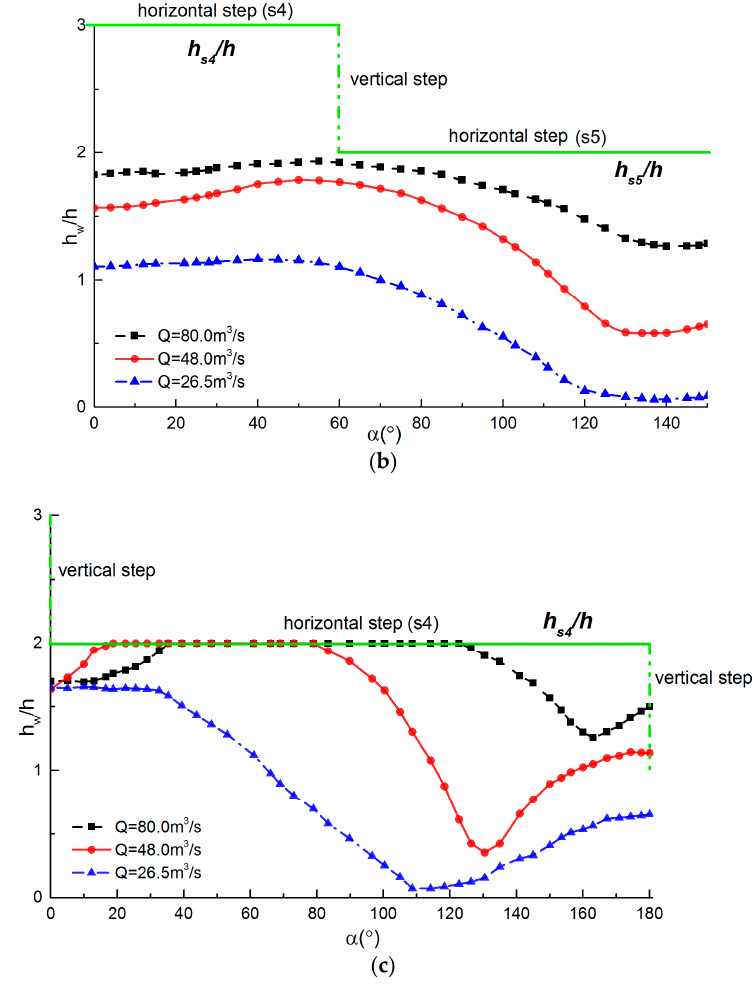
Figure 11. Water surface curves: ( a ) 120°; ( b ) 150°; and ( c ) 180°.